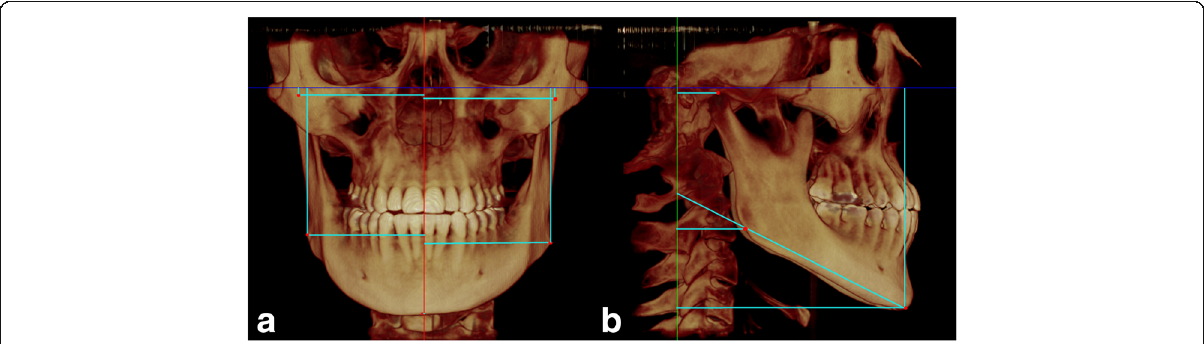
Fig. 3 Three-dimensional representation of linear and angular measurements between mandibular landmarks and the reference planes. a Measurement of the mandibular landmarks related to axial plane ( blue ) and sagittal plane ( red ); b Measurement of the mandibular landmarks related to the coronal plane ( green ) and mandibular plane